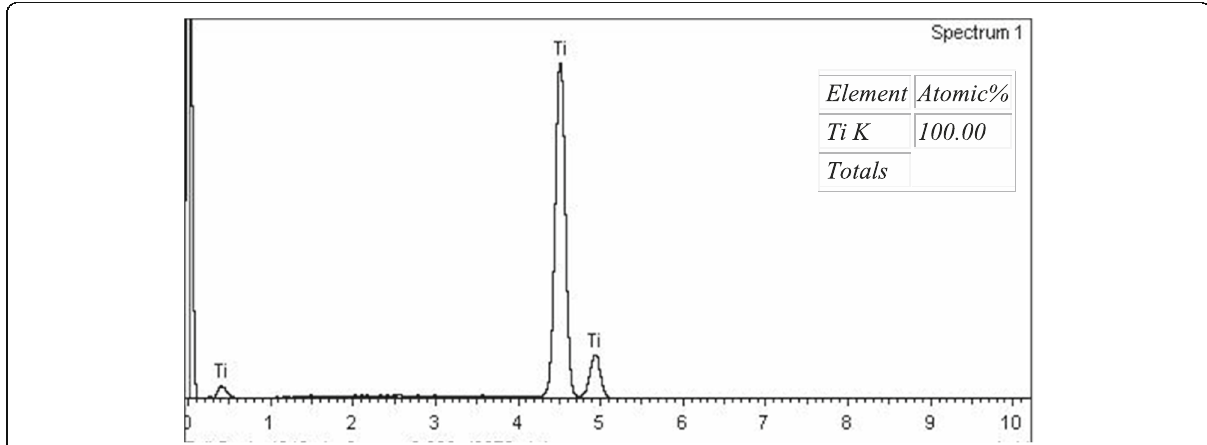
Fig. 11 Energy dispersive spectrum of control Cp titanium